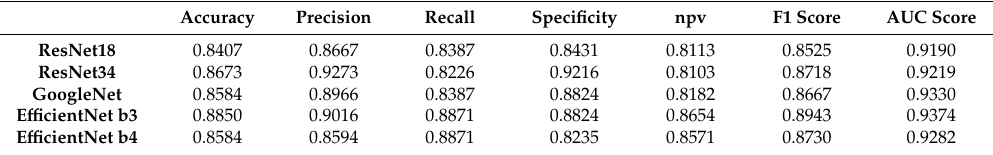
Table 3. Prediction performance on hip radiographic images with clinical covariates.